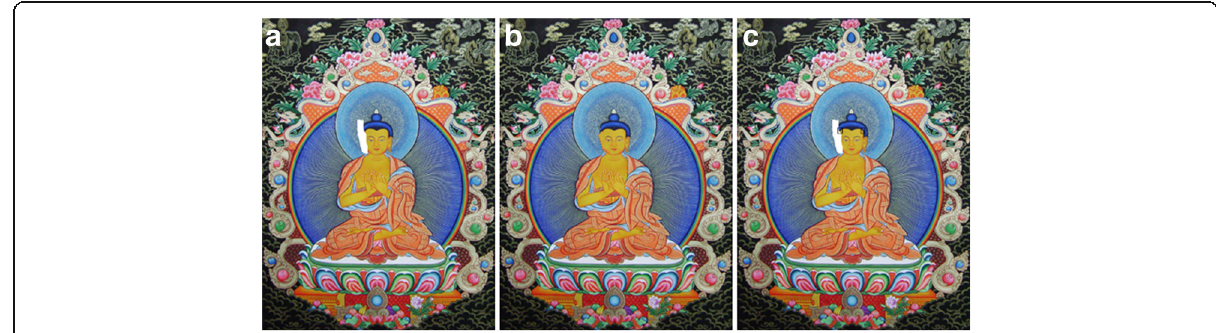
Fig. 2 The only object missing and inpainting. a Damage in one of Dipamkara ’ s ears. b Inpainting result by exemplar-based method. c Sample patch diagram of left and